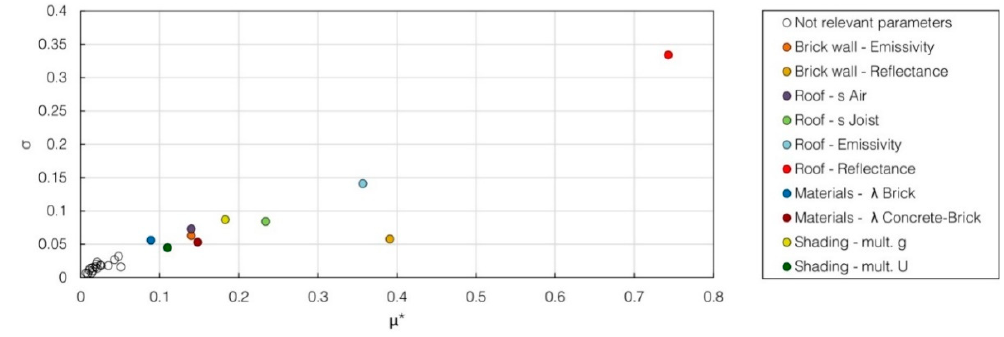
Figure 11. Results for Sensitivity Analysis A. First floor, North exposure.